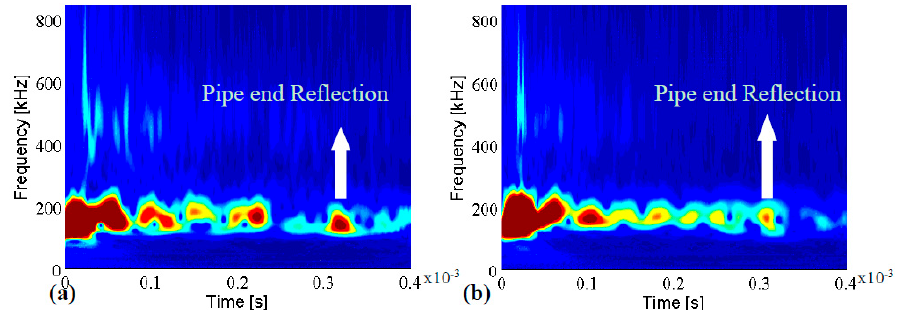
Figure 10. Continuous wavelets transform of the pristine pipe ( a ); and the pipe with corrosion ( b ).